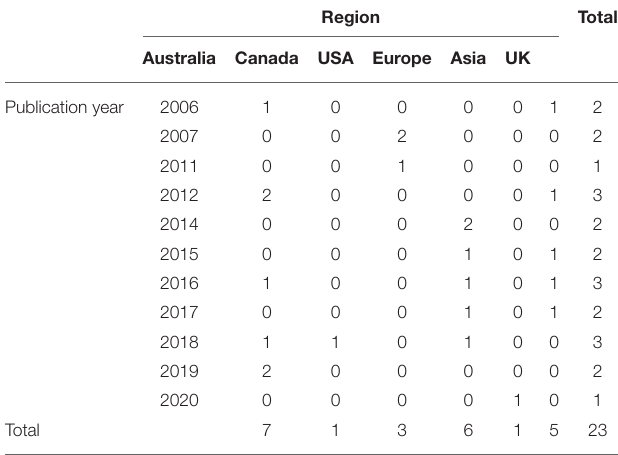
TABLE 3 | Geographical distribution of papers retained for